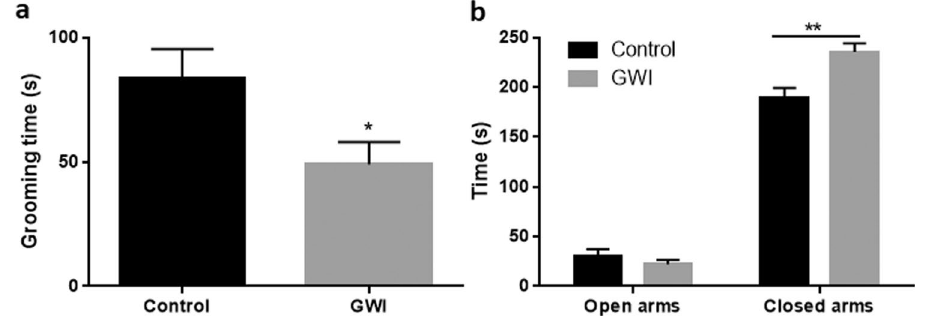
Figure 1. Effects of treatment with Gulf War agents PER + PB on the splash test ( A ) and the elevated plus maze ( B ). Behaviors were evaluated 6 weeks after administration of the agents to corroborate that the GWI model induced some of the outcomes reported for this condition. Results are mean ± SEM, N = 5–6. Symbols represent significance levels for the indicated comparisons as p < * 0.05, **